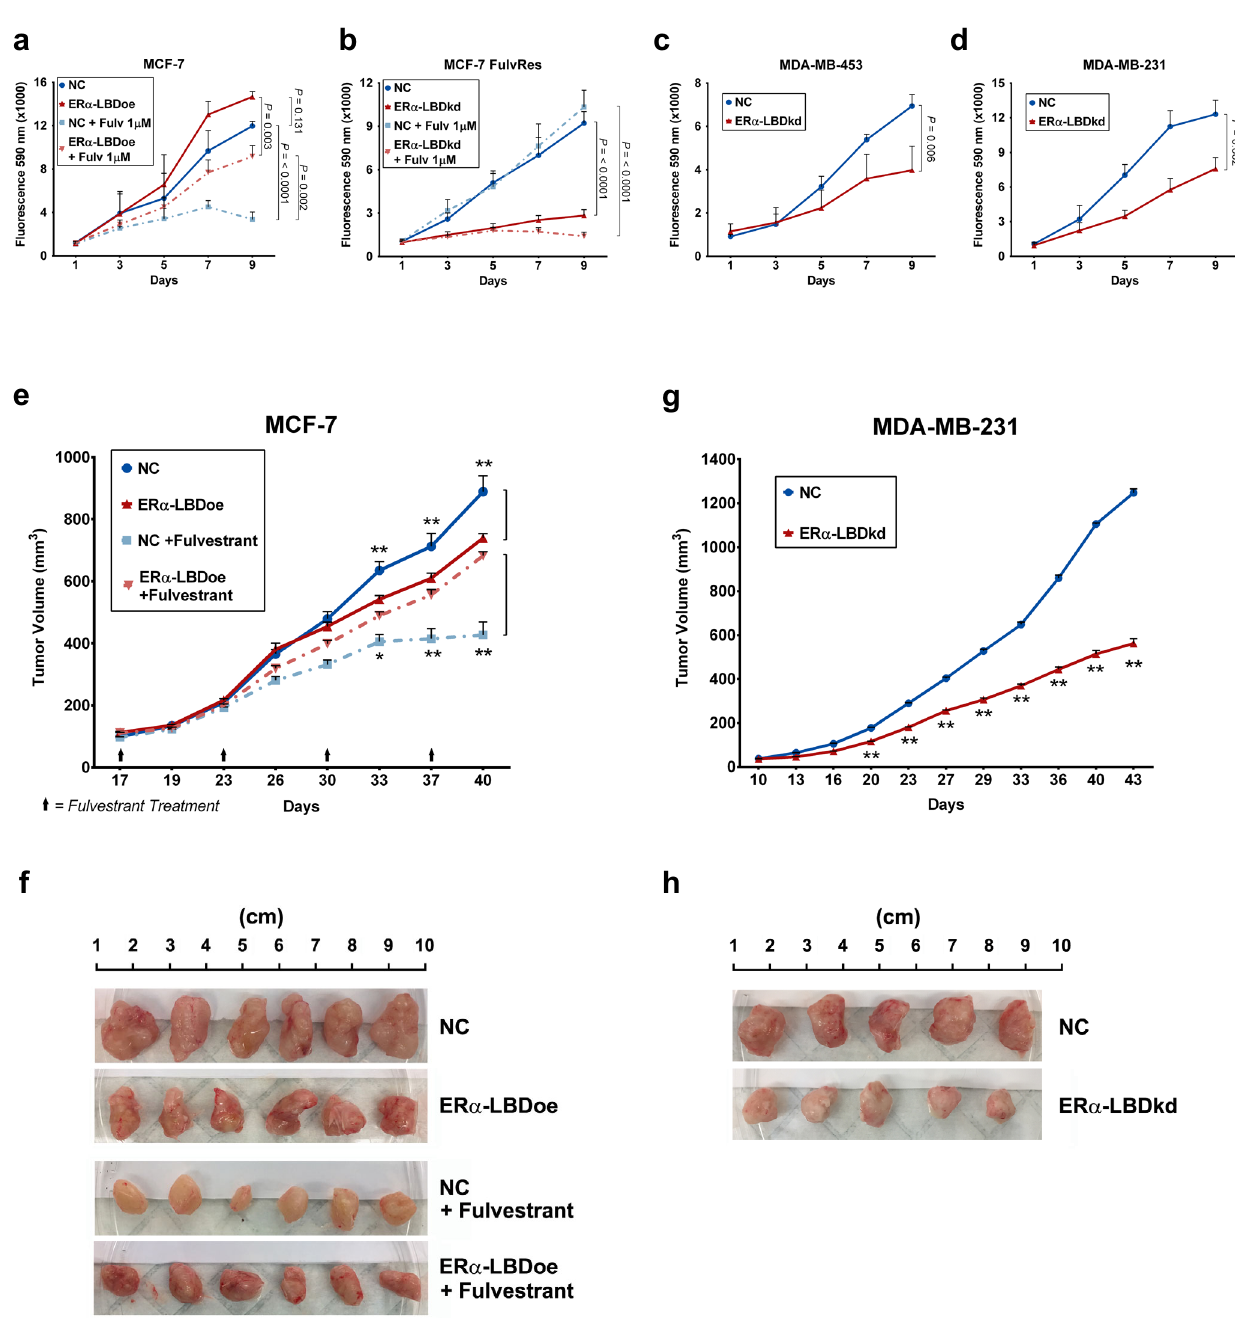
Fig. 6 ER α -LBD promotes in vitro and in vivo growth and fulvestrant resistance. a – d In vitro proliferation of BC cell clones, using resazurin reagent and expressed as fl uorescence intensity (absorbance at 590 nm). ER α -LBD overexpression ( a ) or knockdown ( b – d ) was compared to controls (NC). In a and b , cell proliferation was also tested in the presence or absence of fulvestrant 1 µM treatment ( n = 3 independent experiments). All P values describing statistical differences between samples are shown. e – h Xenografts of BC cells implanted into the mammary fat pads of NOD scid gamma (NSG) mice. Plots in e and f show mean tumor volumes (mm 3 ) as a function of time (days). MCF-7 model: when tumors reached 100 mm 3 , mice were randomized ( n = 6/group) to weekly treatments with 200 mg/kg fulvestrant injected intramuscularly, and compared to control groups ( n = 6/group). MDA-MB-231 model: n = 5/group. f – h Images and size of tumors, isolated from animals after reaching endpoint. In a and e , NC is in blue and ER α -LBD overexpression in red. In b – d and g , NC is in blue and ER α -LBD knockdown in red. All data in the fi gure are presented as mean ± s.e.m., ns not signi fi cant, * P < 0.05, ** P < 0.01, two-way ANOVA. Source data are provided as a Source Data fi attachment (3-D growth) either in the presence or absence of fulvestrant treatment (Supplementary Fig. 6b), whereas ER α -LBD knockdown led to reduced 3-D growth in both MDA-MB-453 and markedly reduced, when compared to NC group (Fig. 6g, h). MCF-7 − 231 cells (Supplementary Fig. 6c). Similarly, the migratory capacity ER α -LBDoe cells showed a growth advantage when cultured in low-